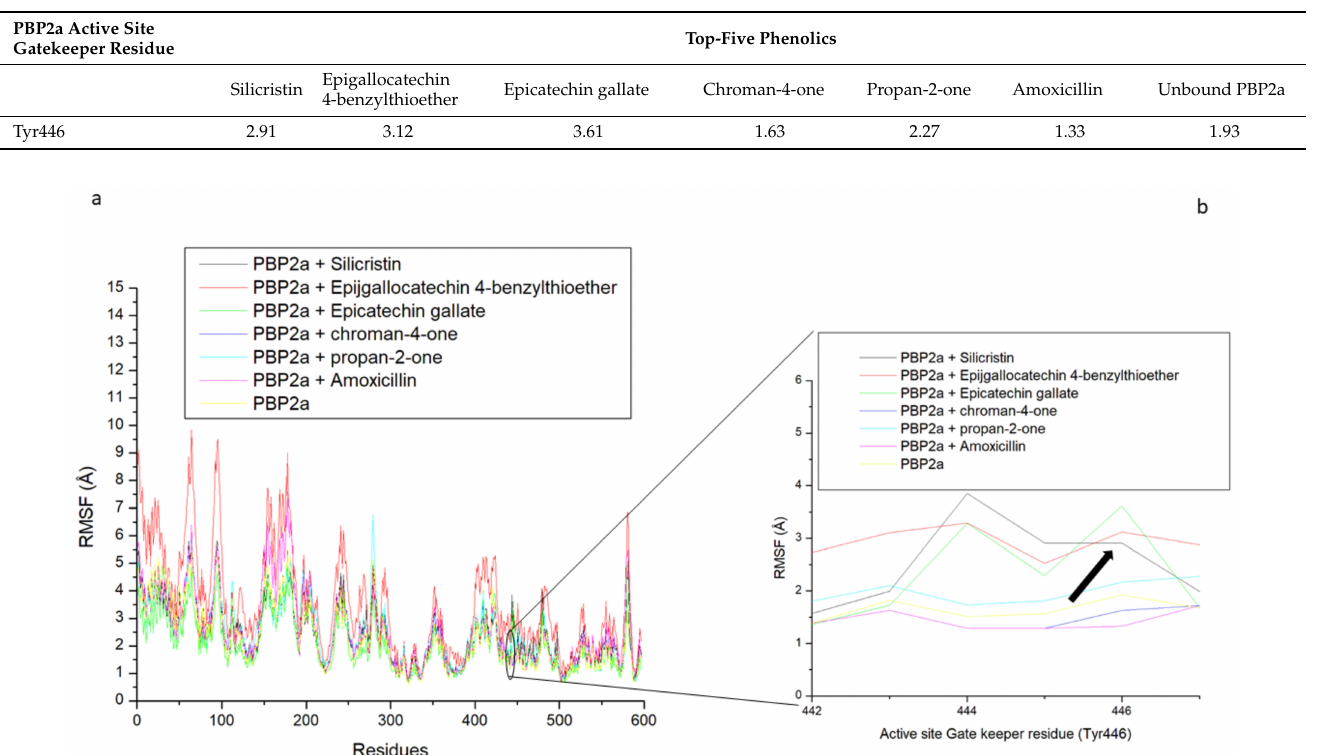
Figure 10. Comparative root-mean-square fluctuation (RMSF) plots of alpha-carbon, the top-five phenolics, and amoxicillin against residues of PBP2a of S. aureus ( a ), and gatekeeper residues [Tyr446 (black arrow)] of PBP2a ( b ) when the top-five phenolics and amoxicillin were bound at the allosteric site of PBP2a over a 120 ns MD simulation period.